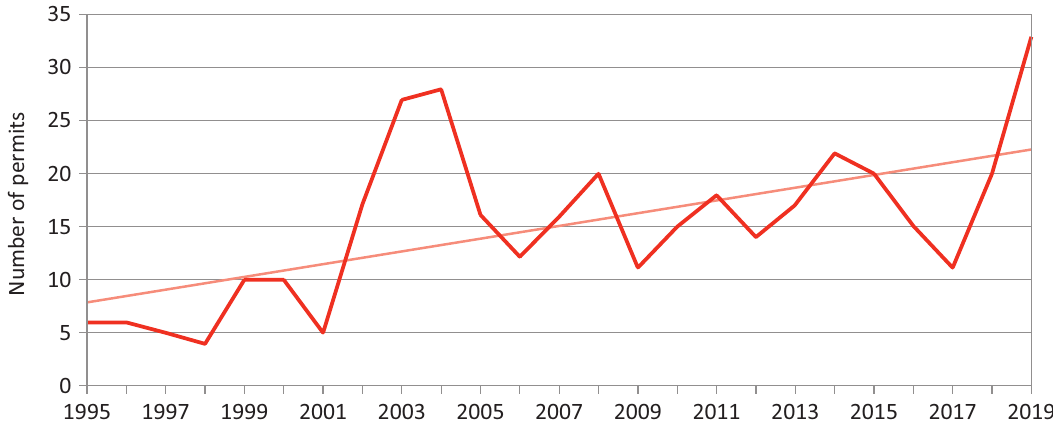
Figure 1. Number of permits for industrial conversions in Sint-Jans-Molenbeek between 1995 and 2019. Source: Courtesy of the Urbanistic Department of Sint-Jans-Molenbeek, processed by Sarah De Boeck. non-profit organizations, of which half turn their indus- trial property into places of worship, principally mosques and evangelical churches. Fewer than 4% of these con- social housing and buildings for social, cultural, and edu- cational services.